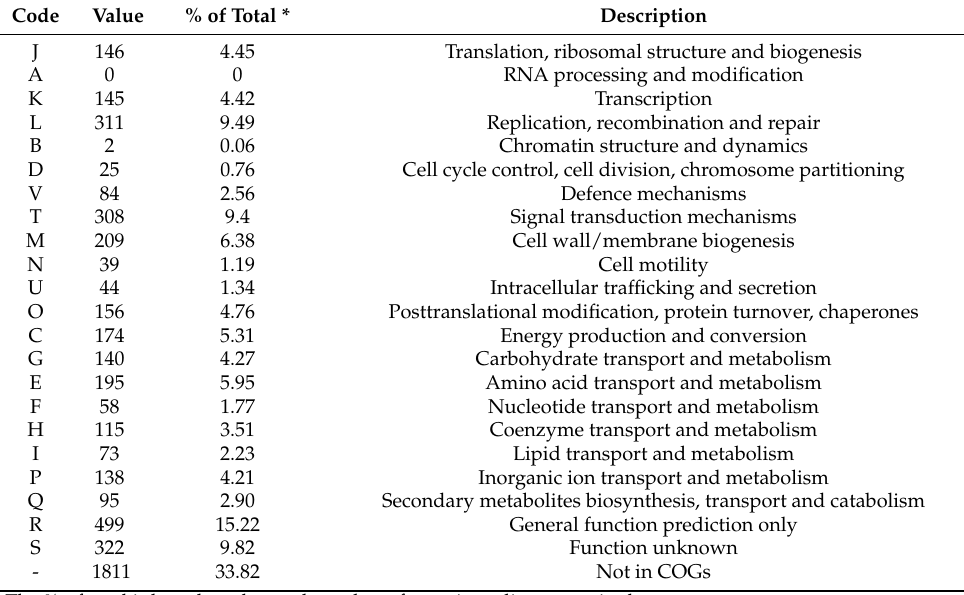
Table 3. The number of genes associated with general COG functional